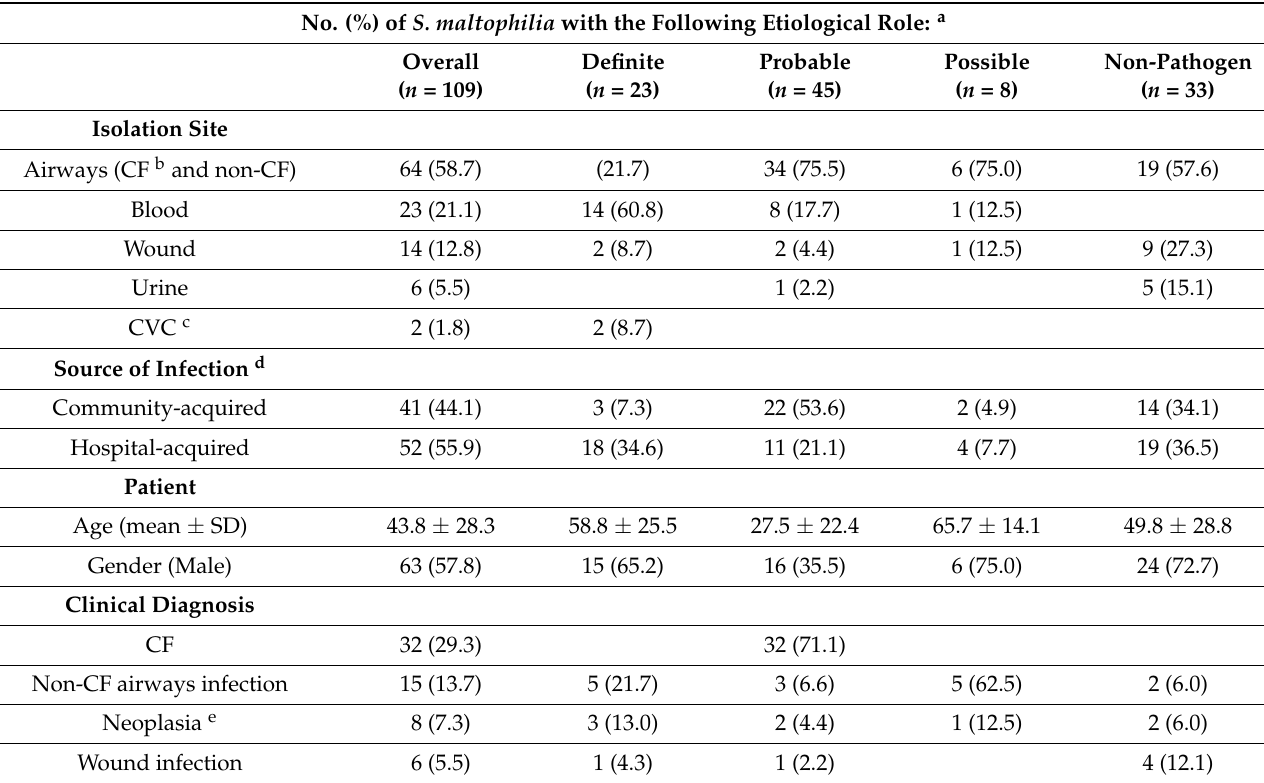
Table 1. Microbiological and clinical characteristics of S. maltophilia strains and patients enrolled in the present study. No. (%) of S. maltophilia with the Following Etiological Role: a Overall ( n = 109)